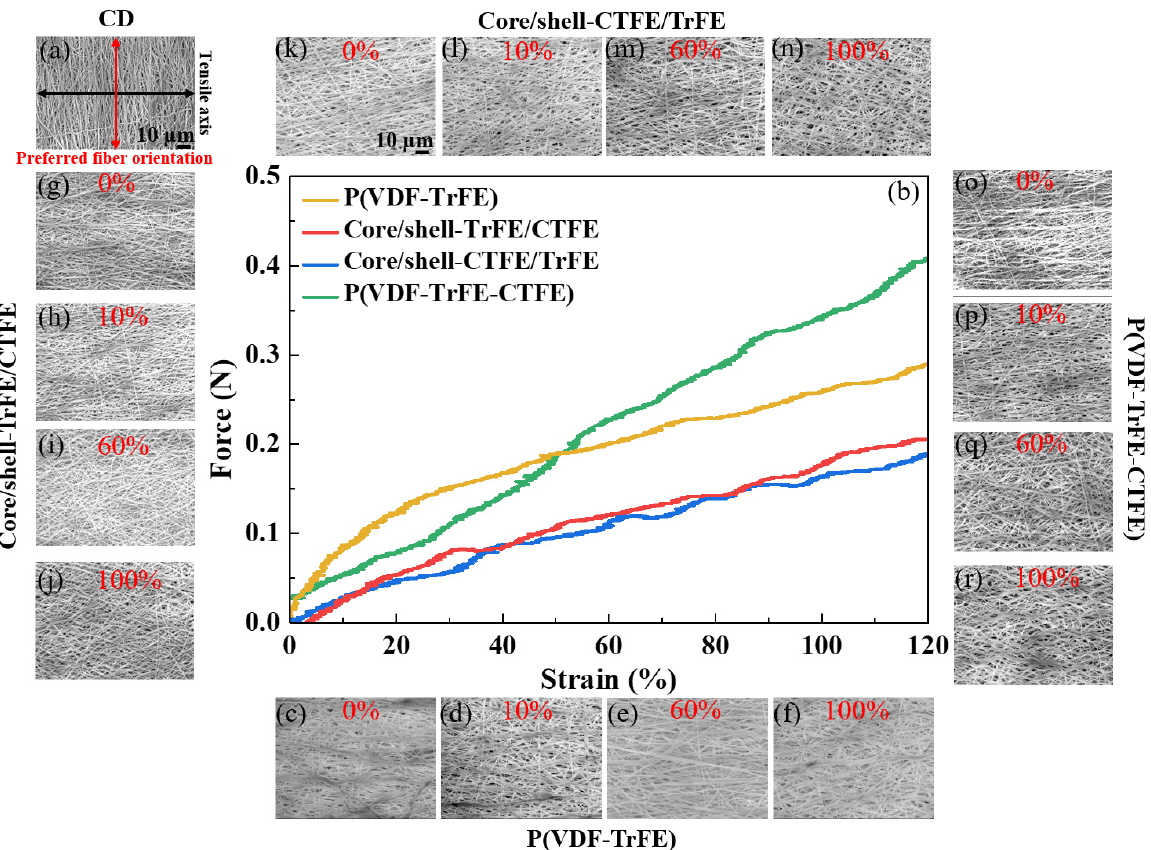
Figure 5. ( a ) Schematic illustration of the tensile test in the CD. The black arrow represents the tensile direction. ( b ) Force-strain curves of the four types of electrospun membranes in the CD. ( c – f ) are SEM images of single P(VDF-TrFE) at the designated strains of 0%, 10%, 60%, and 100%, respectively. ( g – j ) are SEM images of core/shell-TrFE/CTFE at the same designated strains, respectively. ( k – n ) are SEM images of core/shell-CTFE/TrFE at the same designated strains, respectively. ( o – r ) are SEM images of single P(VDF-TrFE-CTFE) at the same designated strains, respectively.